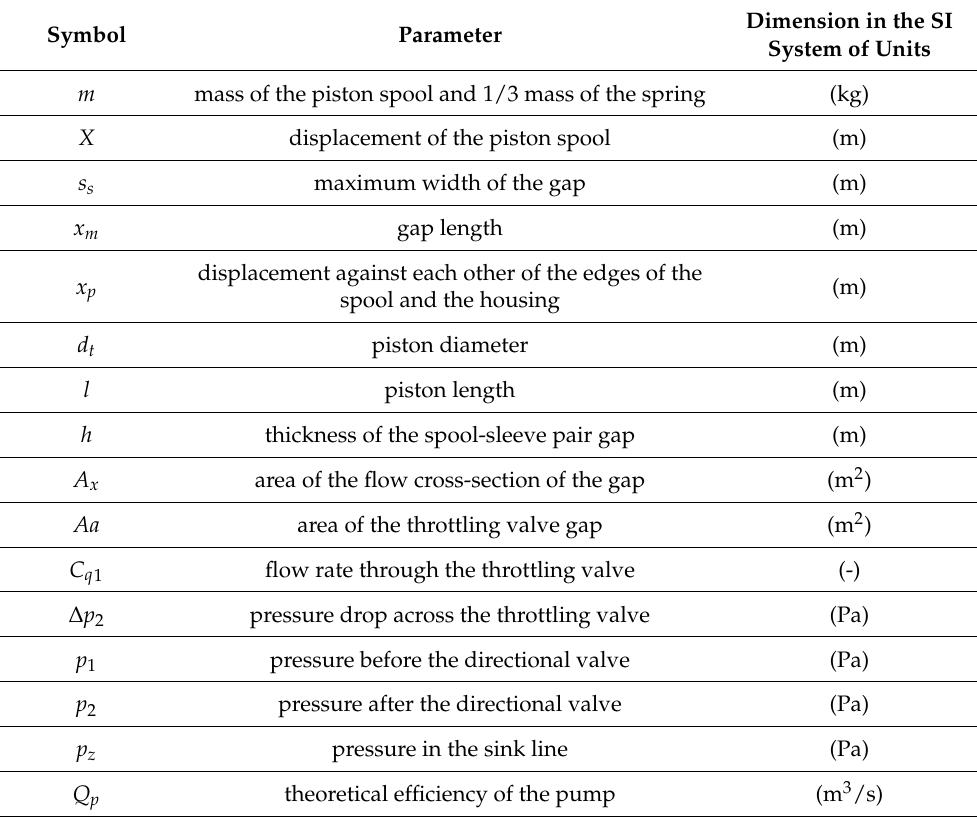
Table 2. List of the more important parameters of Equations (2) and (3) for the mathematic